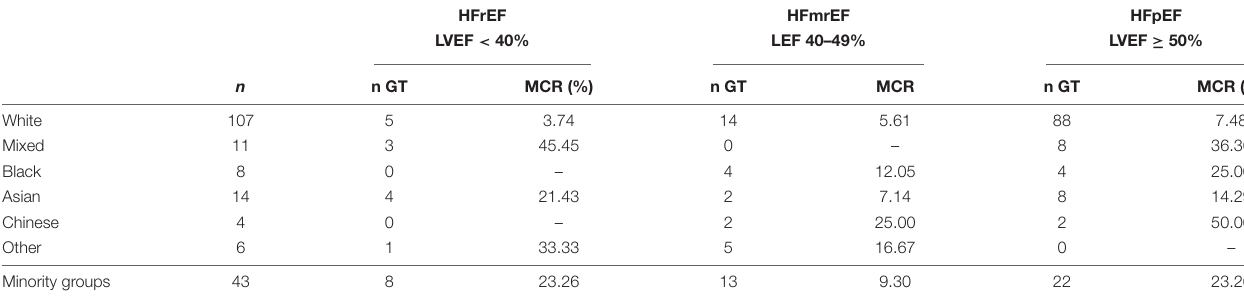
TABLE 6 | Misclassification rate for HF